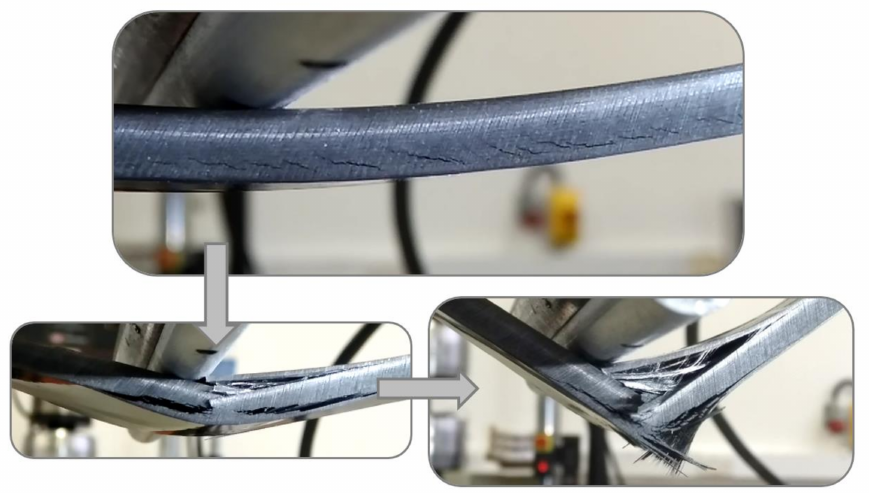
Figure 10. Damage evolution in FGPA laminates: sub-critical damage (top image) and critical damage (bottom